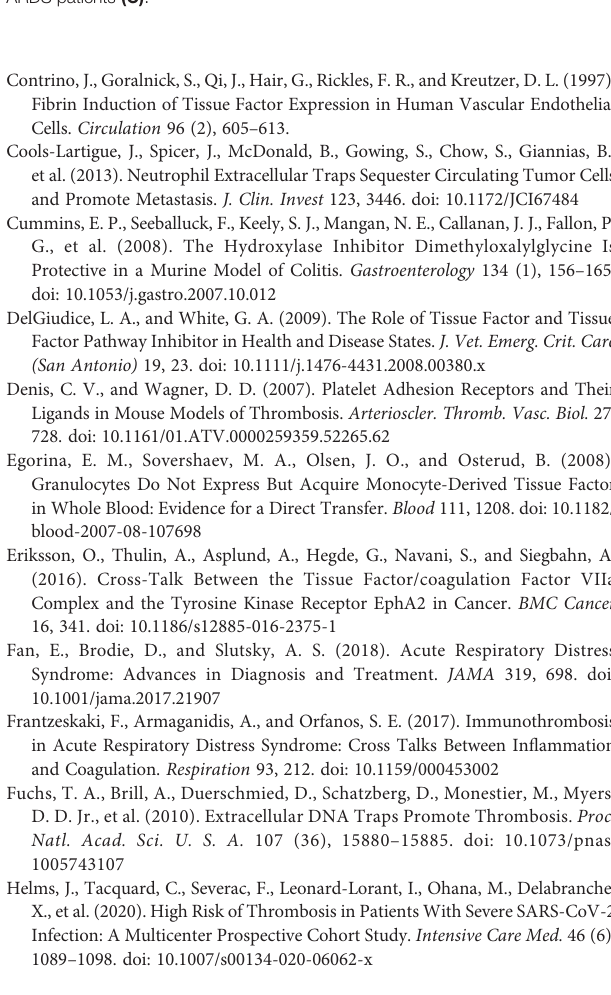
staining analysis of MPO + Ly6G + cell percent. (G) Mouse Lung injury score. (H) IHC staining analysis of CitH3 + MPO + cell percent. Supplementary Figure 2 | NET inhibition in protecting against sepsis-induced lunginjury.IHCstainedNETswithneutrophilelastase(NE)andNEinhibitortodetect NET formation in different groups. Additionally, MPO activity was assessed in each group. (A) Immuno fl uorescence of NETs from mouse blood in red (MPO), green (NE), and blue (DAPI) in different groups. (B) The percentage of NETs releasing cells in each group. (C) MPO activity assay in different groups. Supplementary Figure 3 | Activation status of platelets from different patients and found that platelets from ARDS patients showed increased levels of surface activation markers compared to platelets from sepsis patients or healthy controls.Fluorescence-activated cellsorting analysisofAnnexin Vonplateletsof HC platelets (A) , sepsis patients (B) , and ARDS patients (C) . Supplementary Figure 4 | Activation status of platelets from different patients and found that platelets from ARDS patients showed increased levels of surface activation markers compared to platelets from sepsis patients or healthy controls.Fluorescence-activated cell sorting analysis of CD62P on platelets of HC platelets (A) , sepsis patients (B) , and ARDS patients (C) . Supplementary Figure 5 | Platelet/neutrophil aggregates (CD61+CD11b+) in PMNsisolatedfromARDSpatientscomparedtosepsispatientsorhealthycontrols. Platelet/neutrophil aggregates observed as double-positive CD61/CD11b per 10000 CD11b-positive events with fl uorescence-activated cell sorting analysis in polymorphonuclear neutrophils isolated from blood of HC (A) , sepsis (B) , and ARDS patients (C)